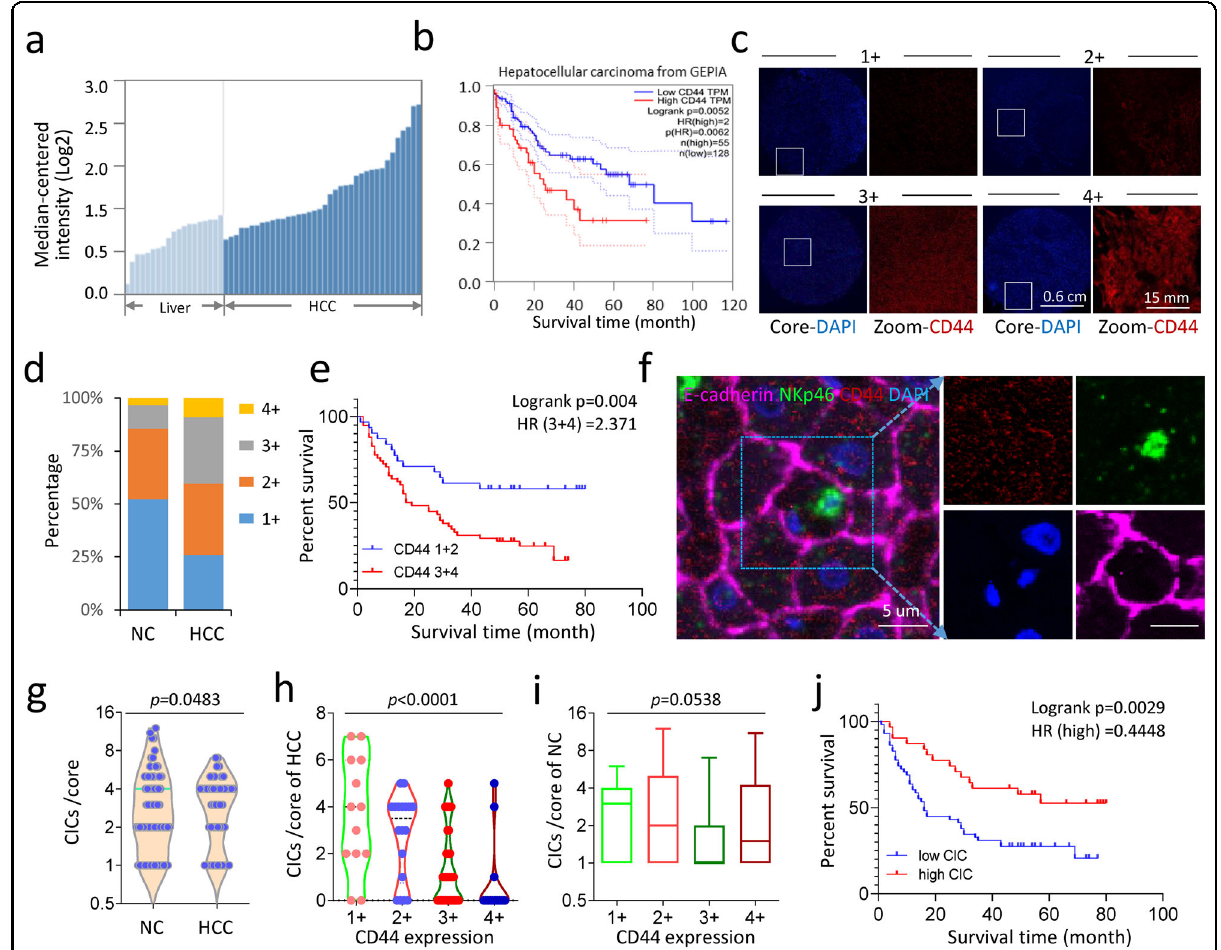
Fig. 7 CD44 expression in tumor tissues is negatively associated with heCIC formation and patient survival. a The expression of CD44 mRNA in HCC tissues was higher than that in non-cancerous liver tissue. Data were retrieved from the Oncomine database. b High CD44 expression is associated with shorter HCC patient survival by Kaplan – Meier plotting of data from the GEPIA database. HR = 2, P = 0.0052, n = 183. c Representative images for four levels of CD44 expression in HCC samples of tissue microarray (TMA) by immuno fl uorescent staining. d Quanti fi cation of CD44 expression in HCC and non-cancerous (NC) liver tissues of TMA. n = 180 with 90 for NC and 90 for HCC, respectively. e High CD44 expression (3 + 4) is associated with shorter HCC patient survival by Kaplan – Meier plotting of data from TMA staining. HR = 2.371, P = 0.004, n = 90. f Representative images of heCIC structure formed in human HCC tissue. Scale bar, 5 µm. g Quanti fi cation of heCIC structures in HCC and non-cancerous (NC) liver tissues of TMA. n = 180 with 90 for NC and 90 for HCC, respectively. h , i CD44 expression is signi fi cantly correlated with heCIC formation in HCC ( h ), but not that in non-cancerous (NC) ( i ) liver tissues of TMA. j High heCIC formation (>2/core) is associated with longer HCC patient survival by Kaplan – Meier plotting of data from TMA staining. HR = 0.4448, P = 0.0029, n =